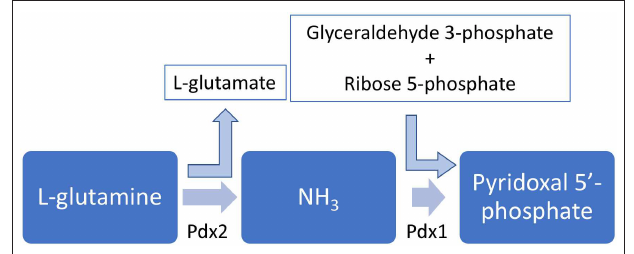
FIGURE 2 | Pyridoxal 5 ′ -phosphate biosynhesis pathway. The enzymes Pdx1 and Pdx2 are simultaneously necessary to synthesize